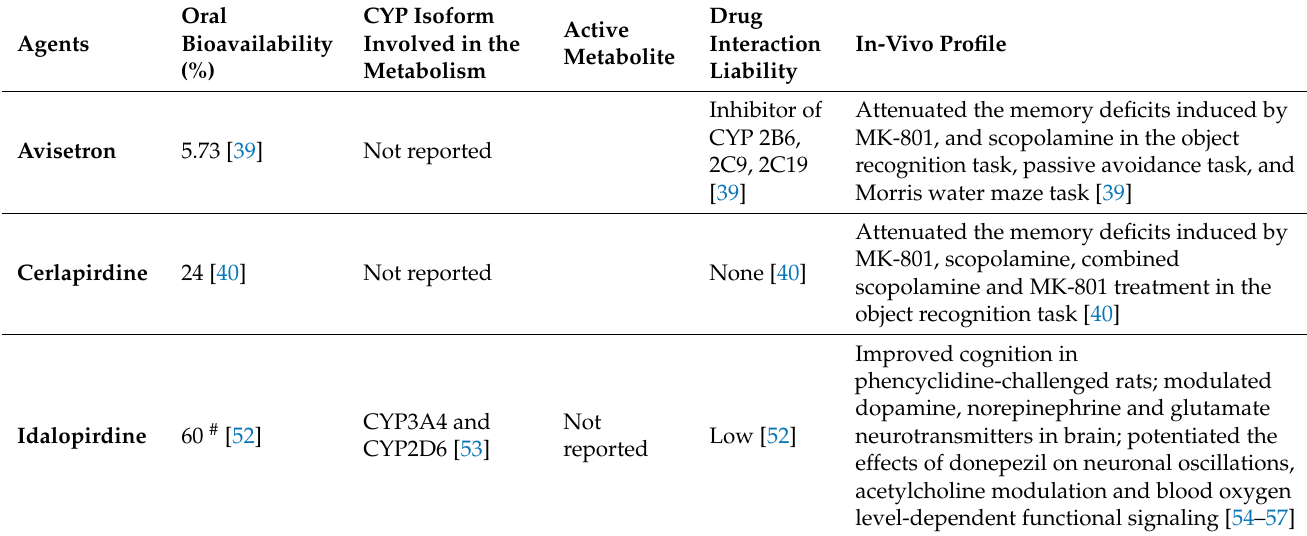
Table 2. Metabolic and In-vivo Profile of 5-HT 6 Receptor Antagonists Recently in